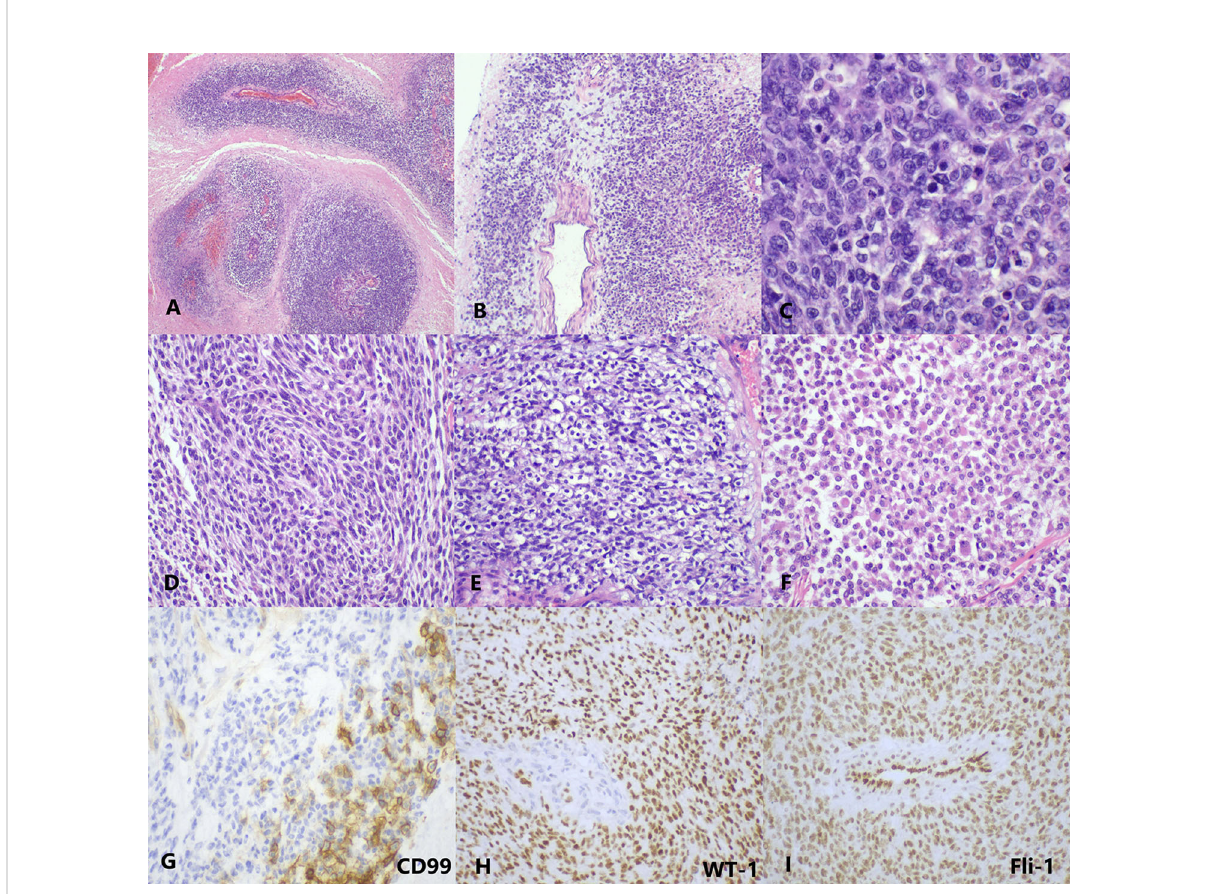
FIGURE 2 The histopathology and immunohistology of CDS. (A) At low magni fi cation, the tumor cells are separated by massive necrosis, arranged in nest-like and perivascular (H&E, ×40). (B) Focal myxoid stroma (H&E, ×40). (C) At high magni fi cation, the tumor cells show round-to-oval shape with lightly eosinophilic cytoplasm and vesicular nuclei; several mitotic fi gures are visible (H&E, ×400). Moreover, (D) spindle cell-like (H&E, ×200), (E) clear cell-like (H&E, ×200), and (F) rhabdoid plasmacytoid tumor cells (H&E, ×200) are also exhibited in some areas. (G) CD99 is focally membranous positive (IHC, ×400). (H) WT-1 (IHC, ×200) and (I) Fli-1 (IHC, ×200) are diffusely nuclear positive. IHC,